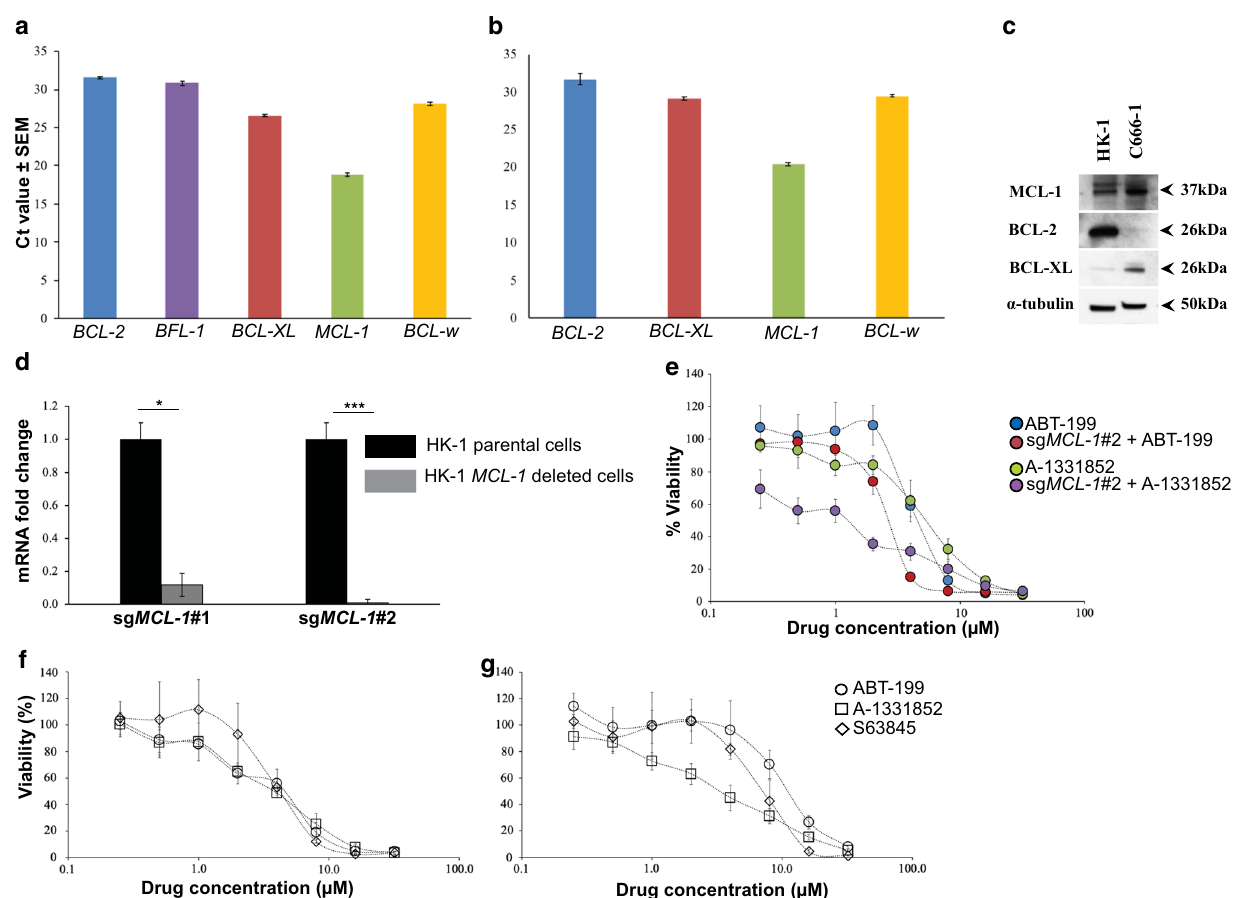
Fig. 1 HK-1 MCL-1 deleted cells were sensitive to treatment of BCL-XL selective inhibitor A-1331852. Expression of the anti-apoptotic genes was determined using the human apoptosis real-time PCR array (RT2 Profiler PCR Array). Ct values are inversely proportional to the amount of target gene present in the cells. The a HK-1 expressed all of the anti-apoptotic genes and b C666-1 expressed all of the anti-apoptotic genes, except BFL-1 . Both cell lines expressed high levels of MCL-1 . Error bars show the standard error of the mean (SEM). c Basal expres- sion levels of the anti-apoptotic protein in the NPC cell lines. The basal expression levels of MCL-1, BCL-2, and BCL-XL in the C666-1 and the HK-1 cells were determined by SDS-PAGE gel electrophoresis (this image was taken from [10] with permission). d qPCR validation MCL-1 gene deletion in the HK-1 cells. MCL-1 expression levels were normalized to parental cells. Bars indicate the mean SEM of three independent experiments. Statistically significant differences in MCL-1 expression between the parental cell line and the MCL-1 knockout cells are shown as ***p ≤ 0.001 or *p < 0.05 determined by a two-tailed paired T-test. e The sensitivity of the HK-1 parental cell line and the HK-1 sg MCL-1 #2 cells were tested to the single-agent treatment of either ABT-199 or A-1331852 (0–32 μM). Points represent the SD of four experiments. f HK-1 and g C666-1 were treated with increasing concentrations of either ABT-199, A-1331852, or S63845 (0–32 μM). Points represent the SD of four